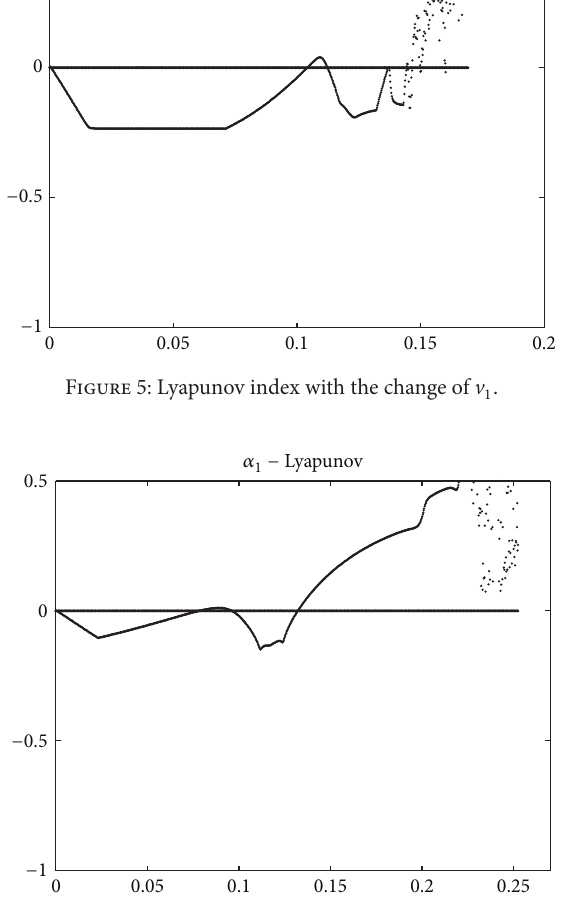
Figure 6: Lyapunov index with the change of 𝛼 1